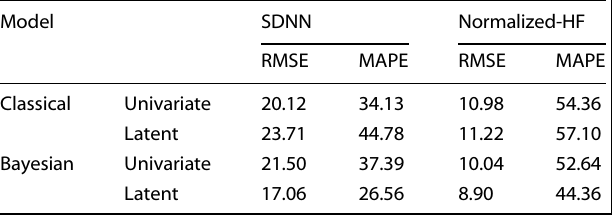
Table 2. Comparing predictive performance of different simultaneous modeling methods.